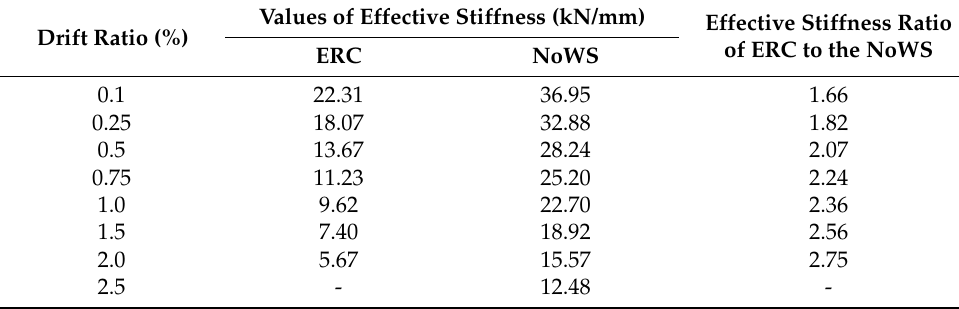
of ERC to the NoWSERC